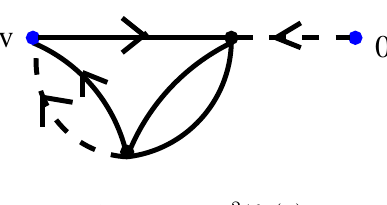
Figure 10 . π 2 K 3 ( v )